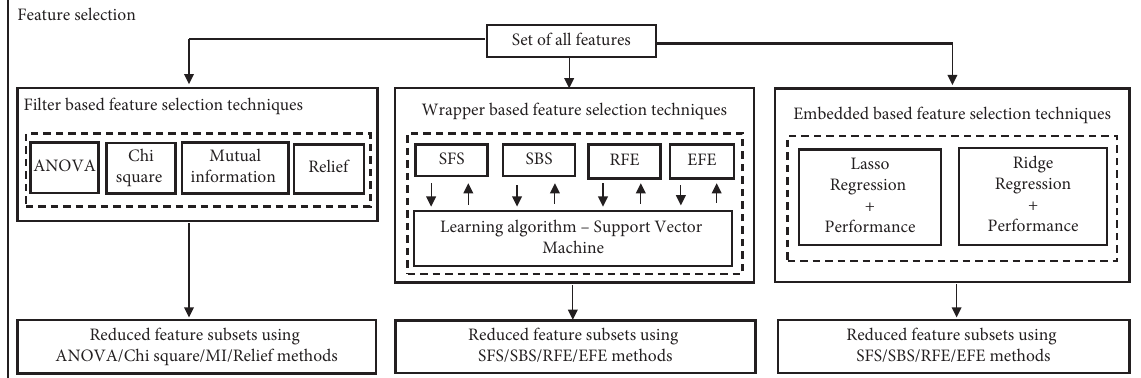
Figure 2: System framework for feature selection.